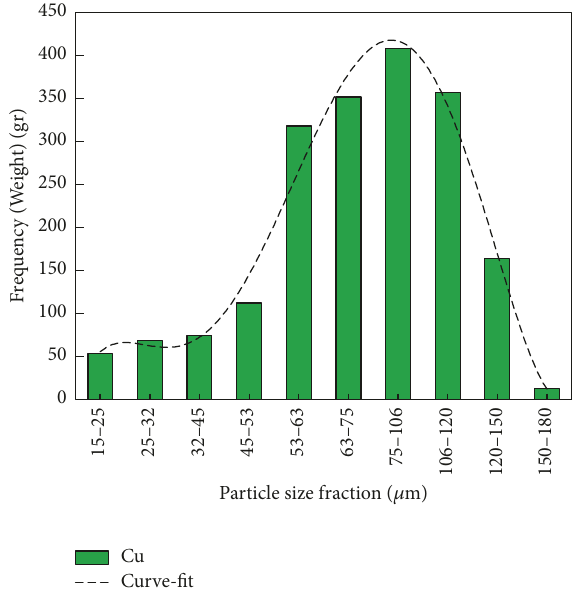
Figure 2: Copper powder particle size distribution.